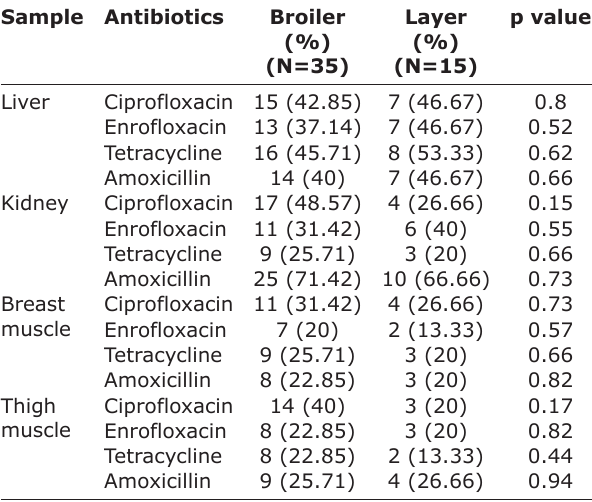
Table-2: Comparison of antibiotics residue between different organ of broiler and layer. Sample